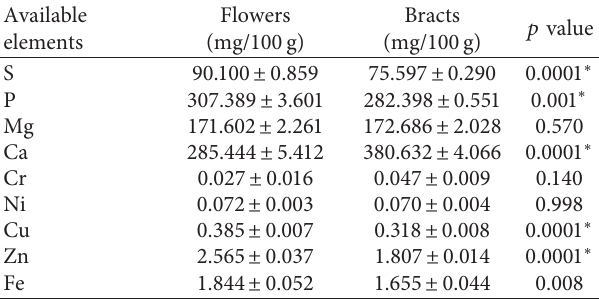
Table 5: Mineral composition of the flowers and bracts in the banana inflorescence by ICP OES